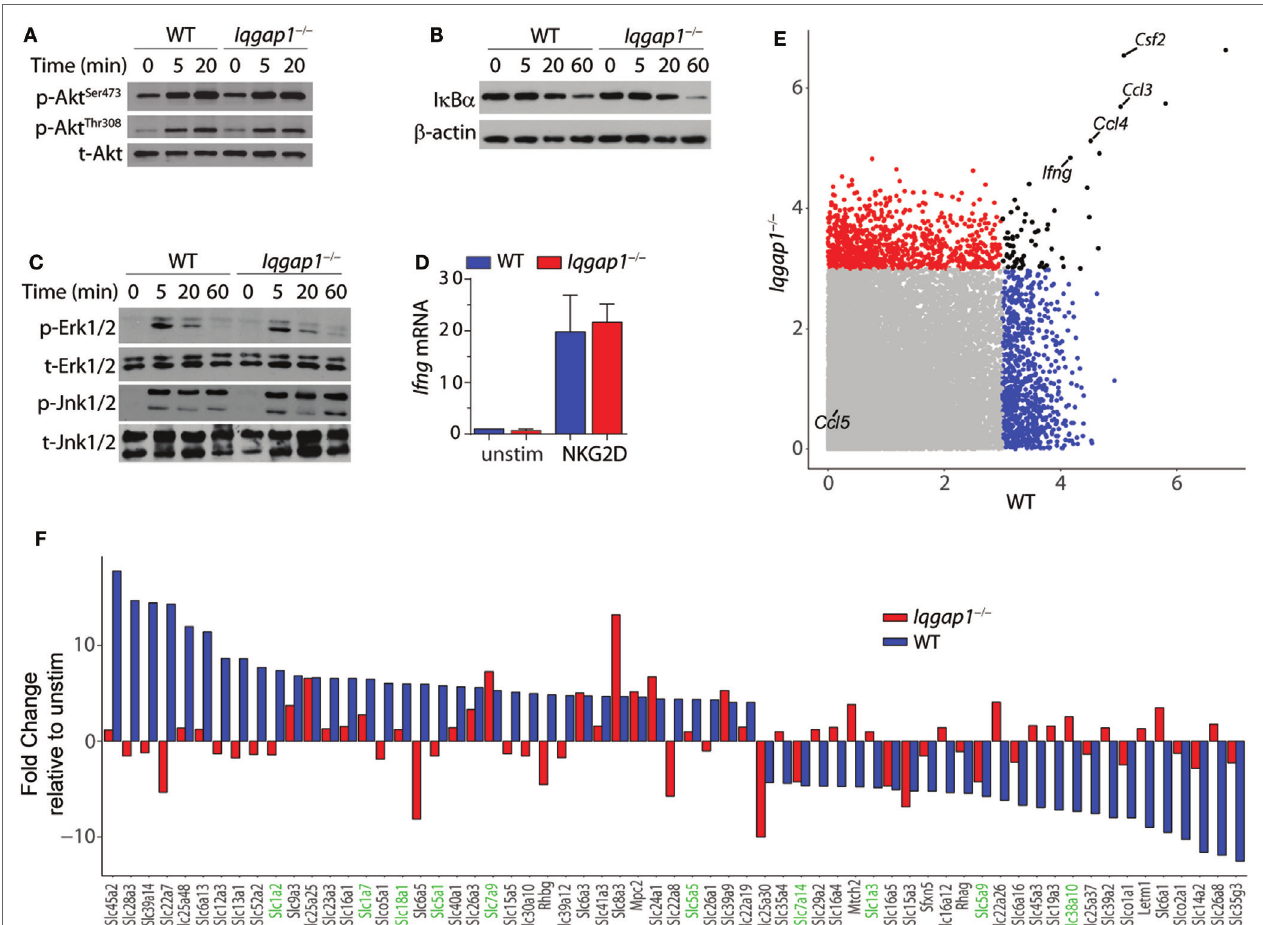
FigUre 6 | NKG2D signaling and induction of cytokine gene transcripts in Iqgap1 − / − natural killer (NK) cells. (a) Phosphorylation of Akt at Ser 473 and Thr 308 was determined by western blot in NKG2D-stimulated wild-type (WT) and Iqgap1 − / − NK cells at 20- and 60-min post-NKG2D activation and total Akt was used as the loading control (B) Degradation of I κ B α is shown after activation with NKG2D in WT and Iqgap1 − / − NK cells at indicated times post-activation with β -actin as the loading control. (c) Phosphorylation of mitogen-activated protein kinases, Erk1/2 (Thr 202 and Tyr 204 ), and Jnk1/2 (Thr 183 and Tyr 185 ), in WT and Iqgap1 − / − NK cells are shown at indicated times post-NKG2D activation with total Erk1/2 and Jnk1/2 proteins serving loading controls. (D) Fold induction of Ifng transcript, relative to unstimulated WT NK cells, was determined by RT-qPCR 4-h post-NKG2D stimulation. (e) Microarray data represented by a scatter plot using a 3-Log2 fold change cutoff. NKG2D-induced cytokine transcripts are labeled. (F) Changes in the induction of solute carrier transcripts. Those that directly regulate amino acid transport are highlighted green. Error bars represent SD using four to five mice in at least two independent experiments (a–D) or four mice of each genotype pooled in one experiment (e,F)